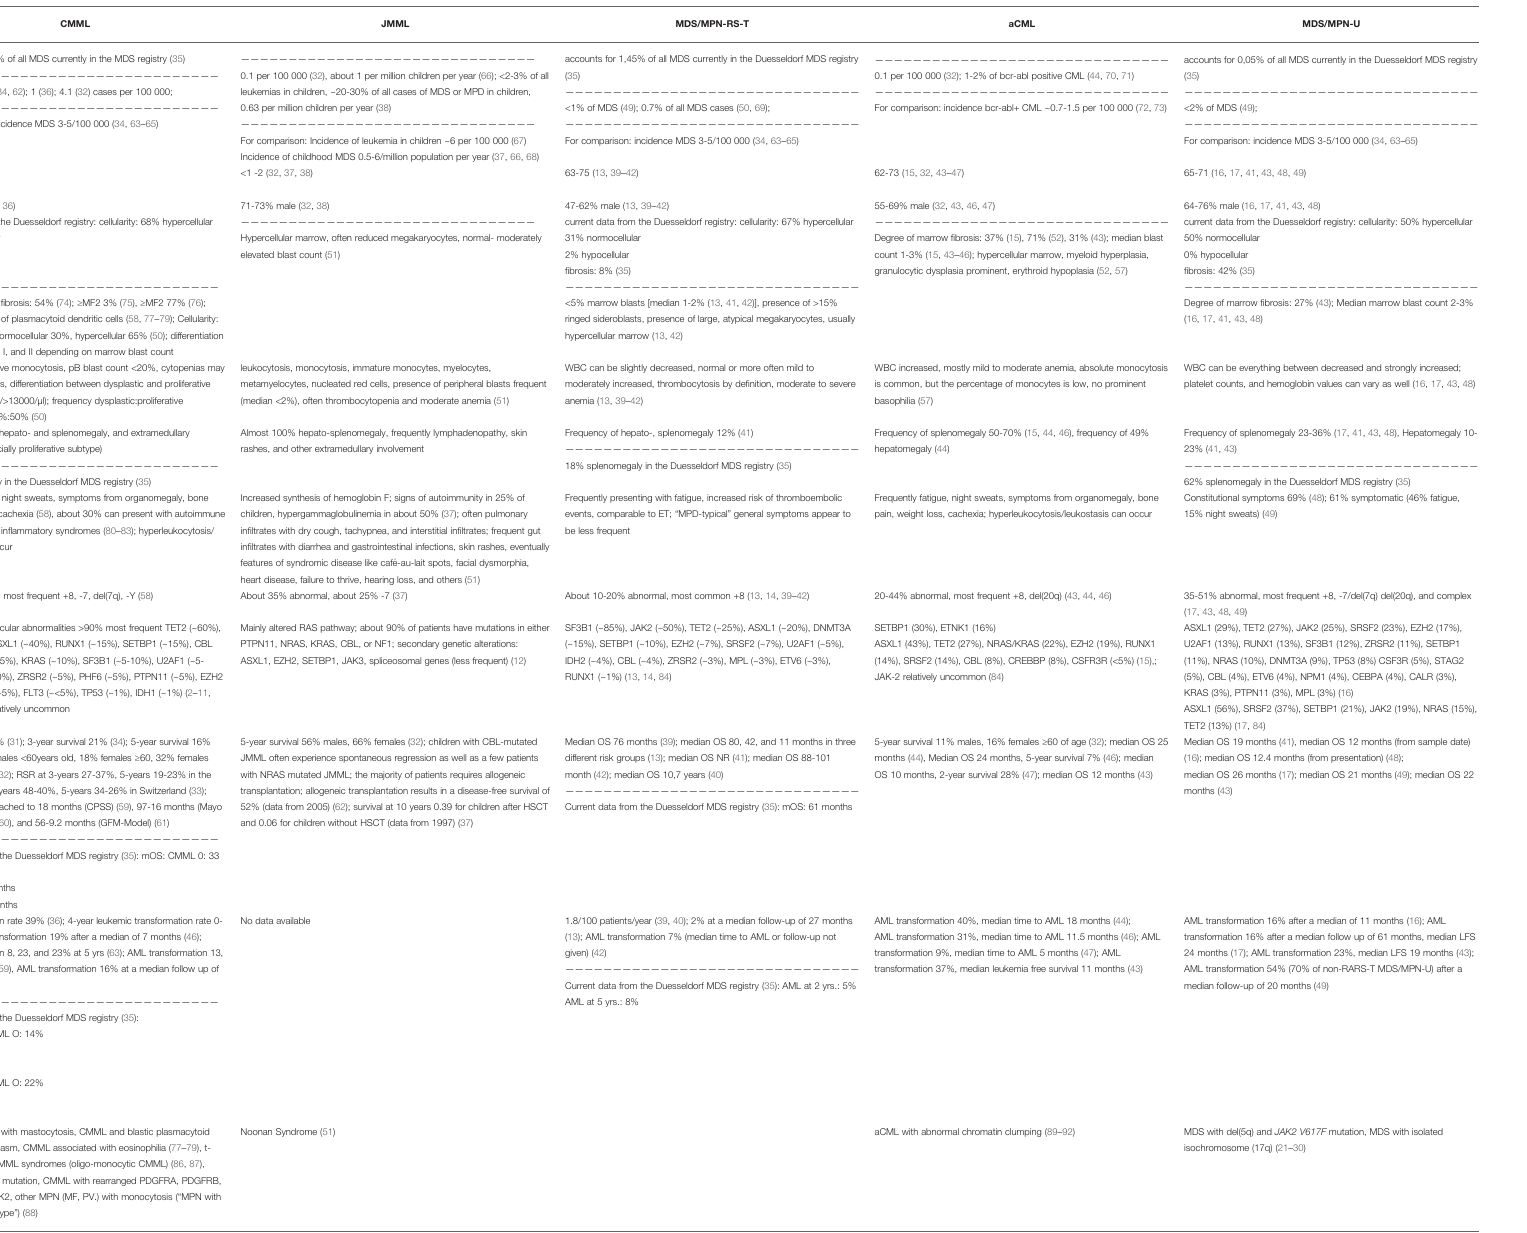
TABLE 2 | Differences and similarities between the